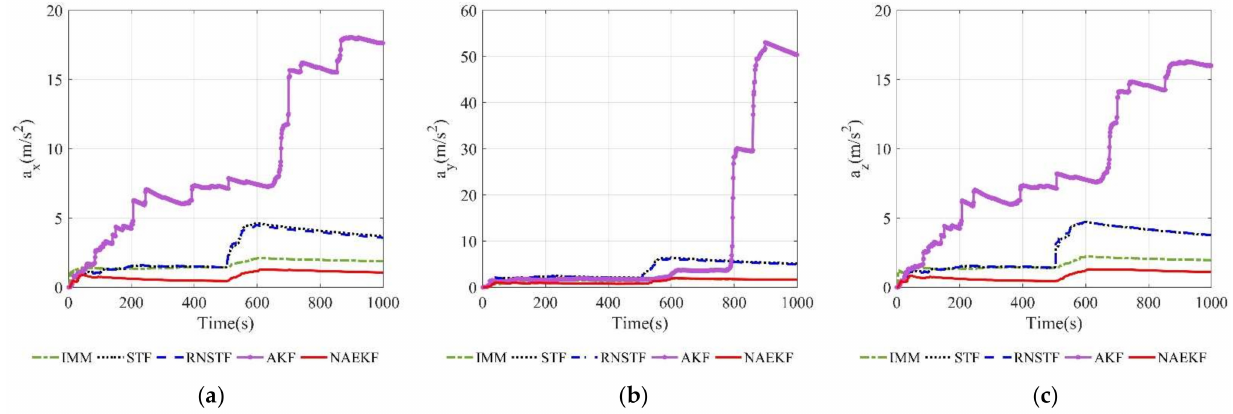
Figure 10. Acceleration estimation errors. ( a ) Estimation errors of a x ; ( b ) Estimation errors of a y ; ( c ) Estimation errors of a z .